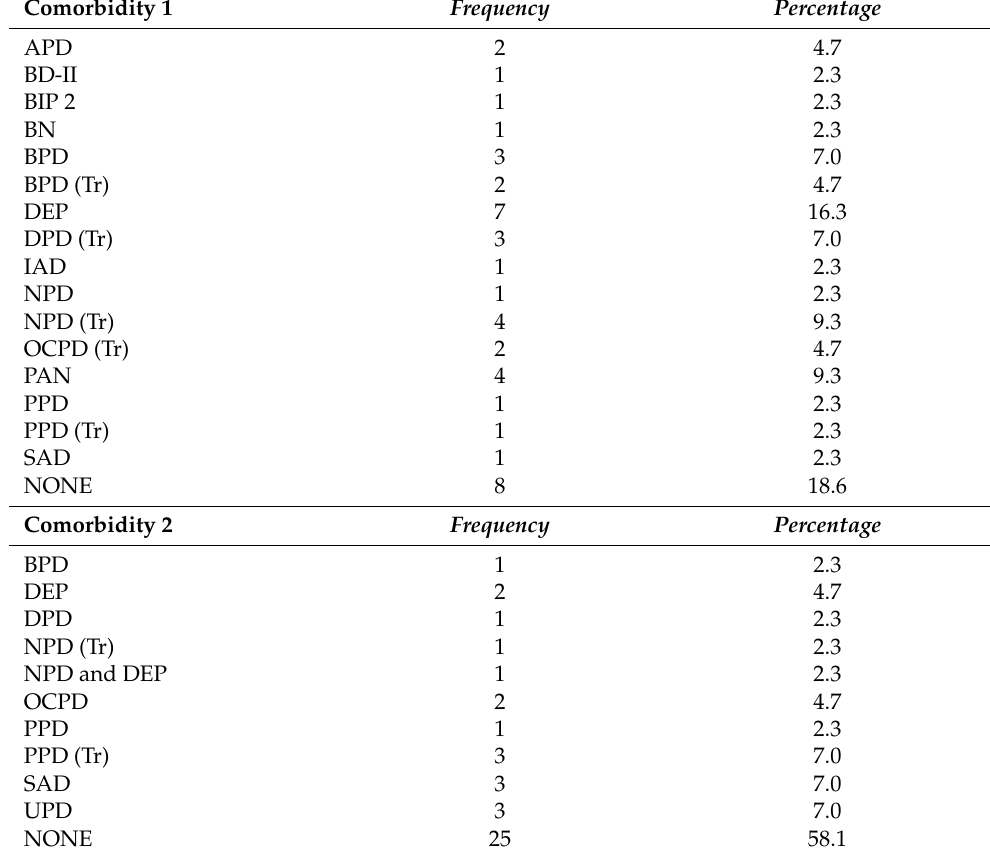
Table 2. Distribution of distinct comorbidities.